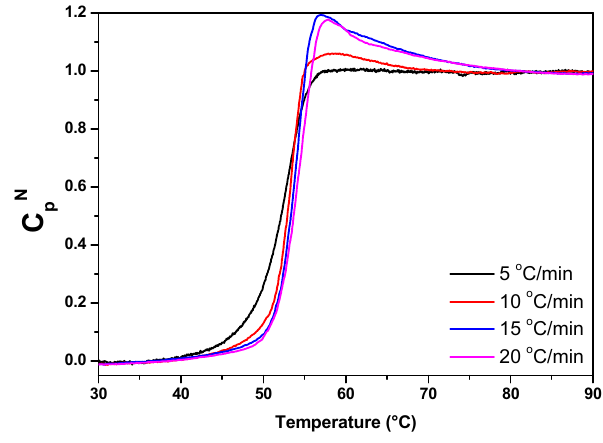
Figure 6. Normalized heat capacity vs. temperature for PMEPF at various heating rates.